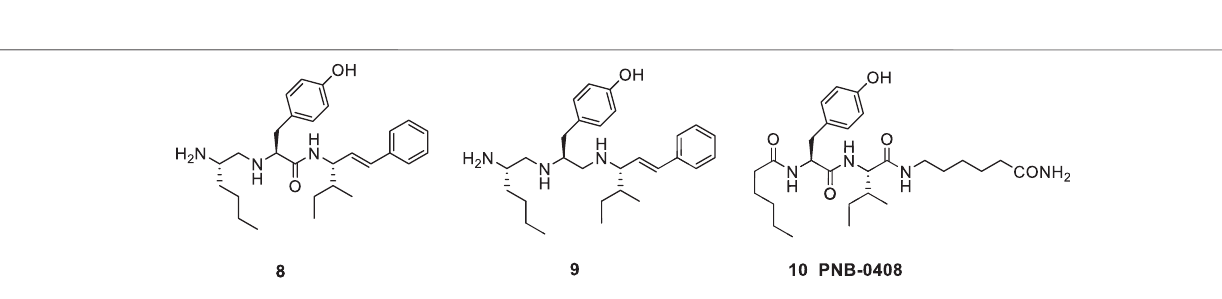
Frontiers in Pharmacology |